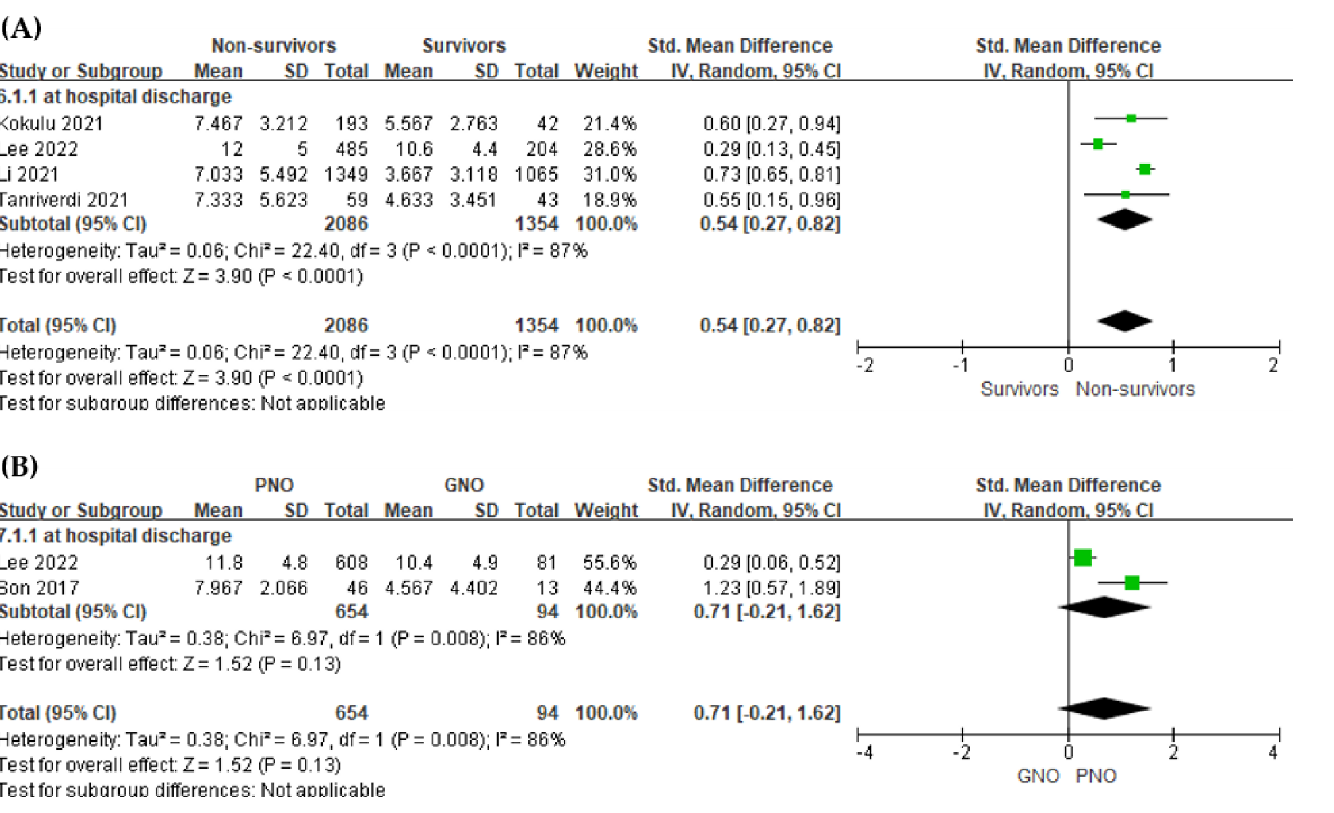
Figure 4. Forest plot of the association between early phase serum lactate level and outcomes of post-cardiac arrest patients. ( A ) in-hospital mortality ( B ) neurologic outcome.